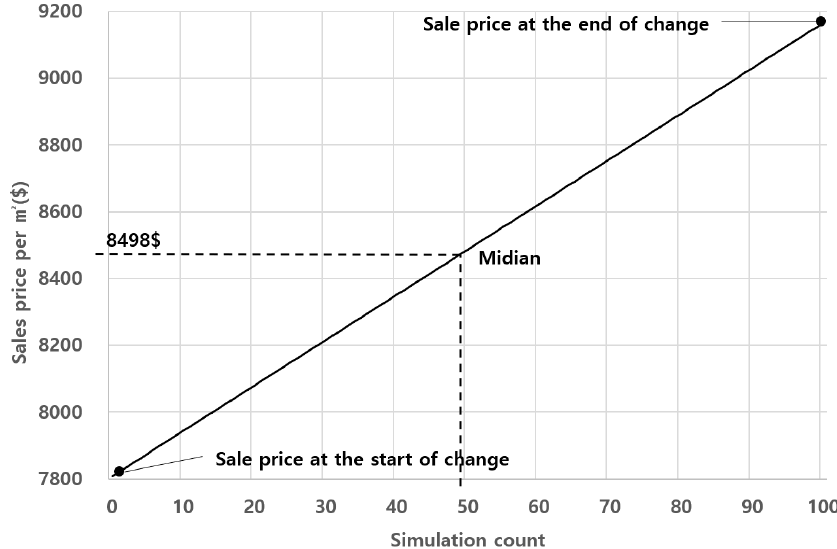
Figure 12. Pre-sale price according to the time of simulation.